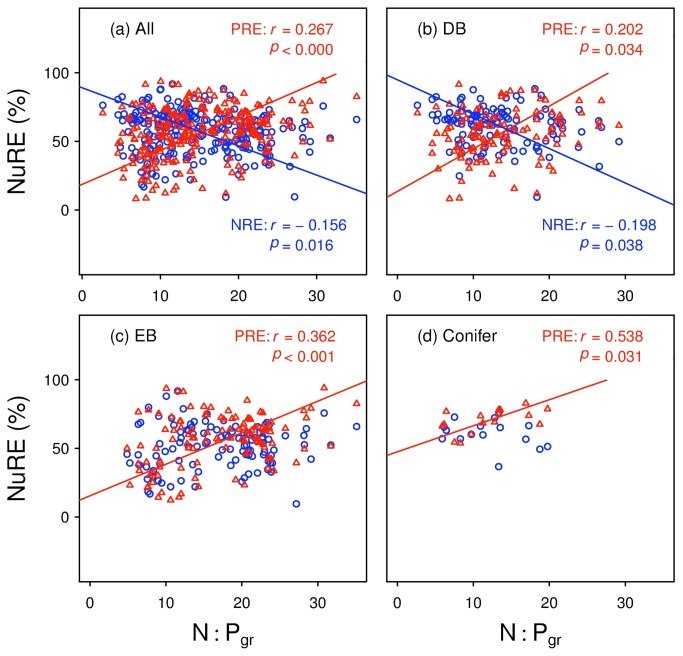
Standardized major axis regression for N or P resorption efficiency (NRE or PRE, NuRE) vs green-leaf N:P ratio for (a) all species; (b) deciduous broadleaf species (DB); (c) evergreen broadleaf species (EB); and (d) conifers.The blue symbols and lines denote NRE, and the red ones represent PRE. Regression lines of NRE vs N:P are not shown in panel (c) and (d) for lack of significant correlations between the two variables in EB and conifers (p = 0.76 and 0.27, respectively).